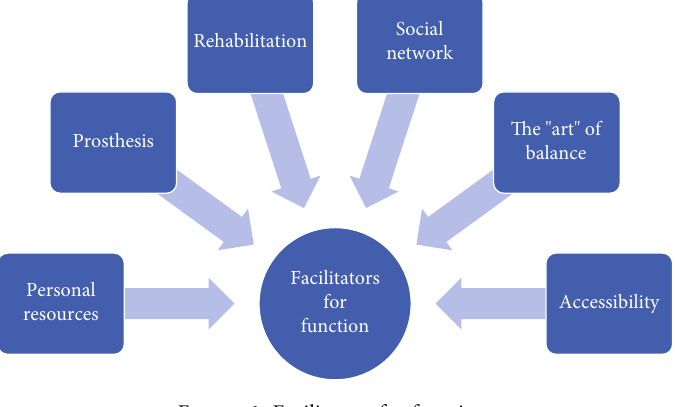
Figure 1: Facilitators for function.